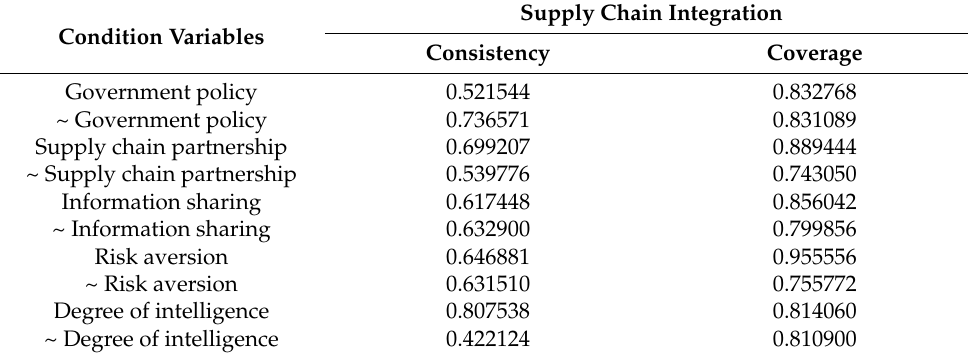
Table 5. Single-factor necessity analysis results of supply chain integration of manufacturing enter-